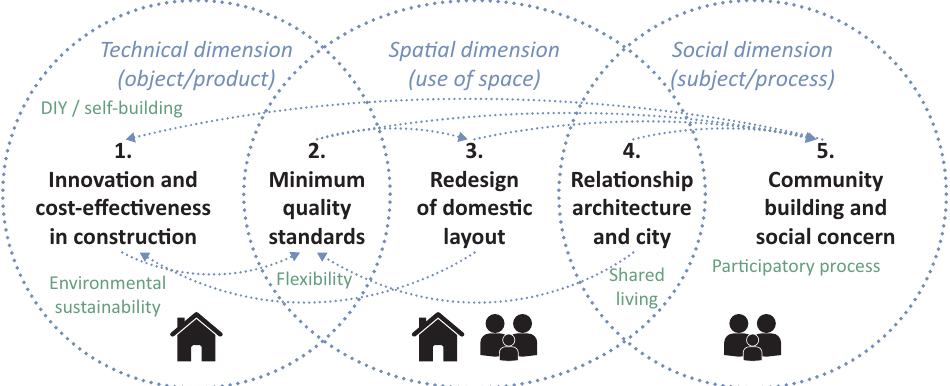
Figure 6. Existenzminimum principles, from a contemporary perspective. Source: author. Urban Planning, 2019, Volume 4, Issue 3, Pages